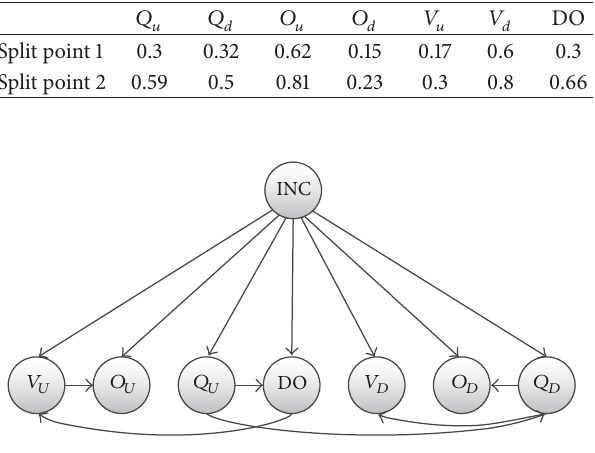
Figure 3: The structure of the TAN classifier for incident detection learned from the training dataset.